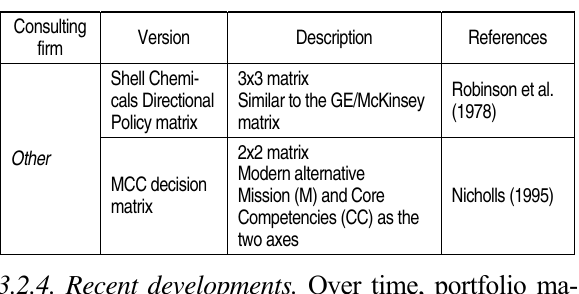
Table 5 (cont.). Portfolio matrices offering by lead- ing consulting